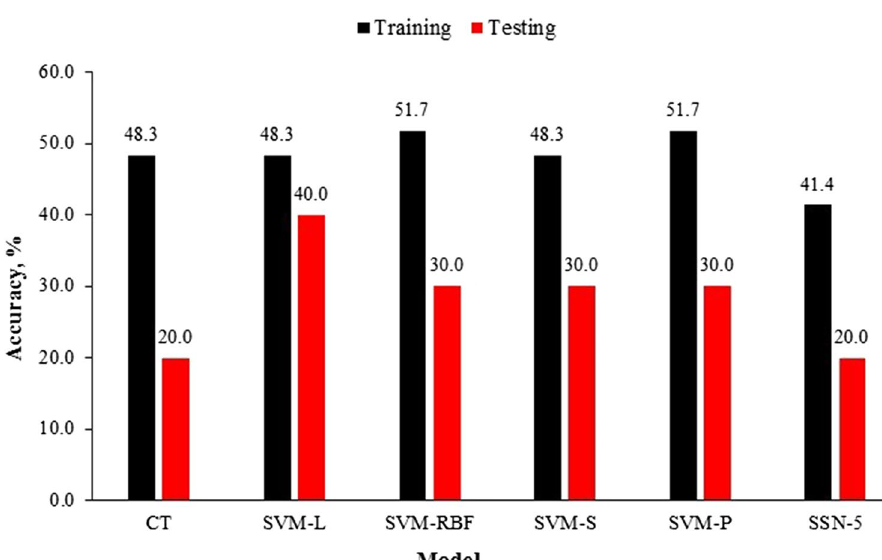
Fig. 2 Classification accuracy of sewer laterals’ damages